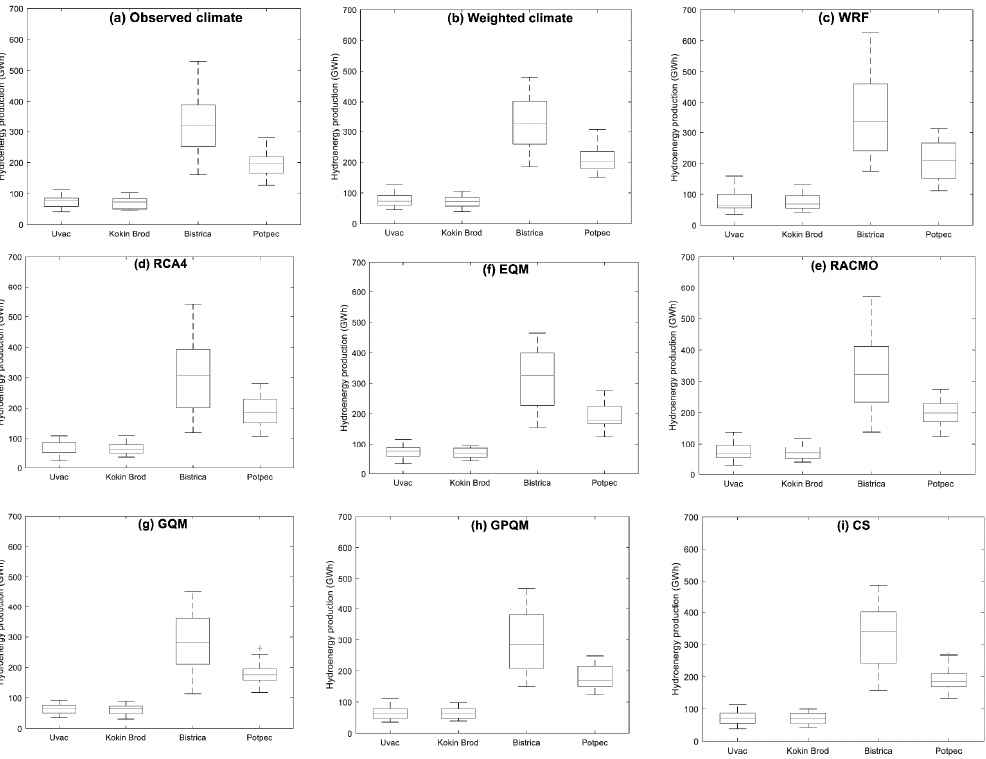
Figure 5. Monthly inflows to and outflows from the Lim water system reservoirs (Uvac, Kokin Brod, Radojnja and Potpec) estimated with the following climate datasets: ( a ) Observed climate, ( b ) weighted climate simulations, ( c – e ) regional climate model simulations—WRF, RCA4, RACMO, ( f – i ) bias correction methods—EQM (empirical quantile mapping), GQM (Gamma quantile mapping), GPQM Gamma Pareto quantile mapping), CS (constant scaling).